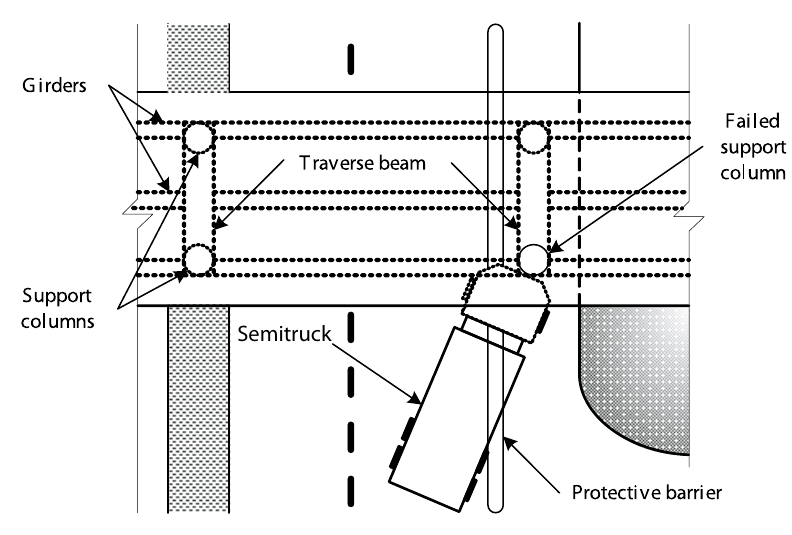
fig. 8. Simplified schematic visualisation of the road 26.5 bridge damaged in Colorado accident